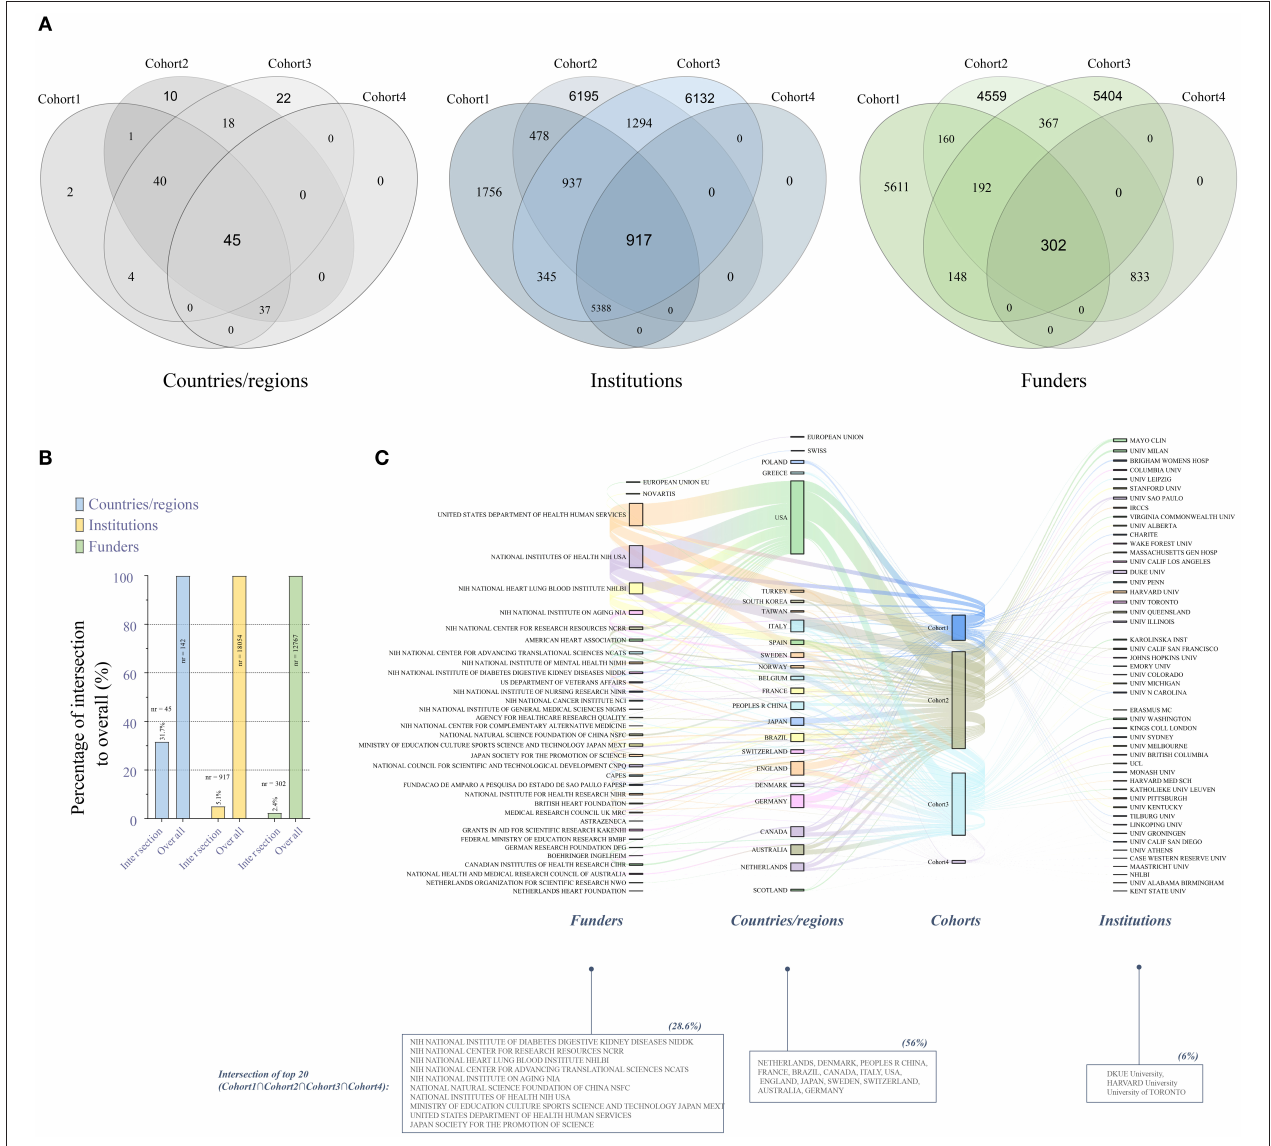
FIGURE 2 | Contributions of countries/regions, institutions and funders to related keyword-driven research. (A) Venn diagram of the distributions of related keyword-driven research by countries/regions, institutions and funders from 2003 to 2020; (B) Percentage of intersection to overall keyword-driven research; (C) Sanky diagram of evaluation of the top 20 institutions and funders in the four keyword-driven